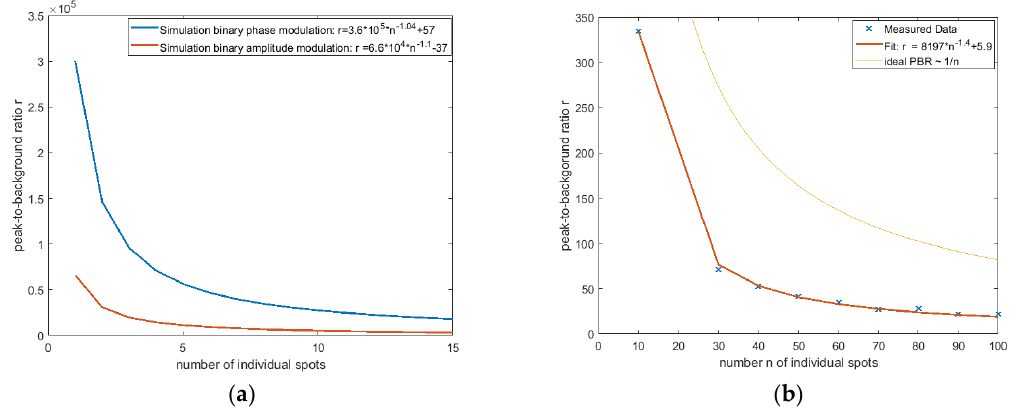
Figure 7 . Mean peak-to-background ratio in dependence of the number of foci created on the sample. ( a ) Comparison of simulated binary phase-only modulation as with our FSLM and simulated binary amplitude modulation as with a digital micromirror devices (DMD). On average, binary phase-only modulation yields an about 6 times higher PBR as well as a lower increase in background noise with higher spot number as indicated by the lower exponent of n . ( b ) Measured Data using the fast FSLM. Due to the design of the modulator and the overall setup, only 11.1% of the light arriving on the modulator is available on the sample surface. The maximum available power density in one spot, however, can be estimated to 1.5 W/mm 2 . This is three orders of magnitude above the EC50 for activating ChR2, which is 1 mW/mm 2 [40]. For stimulating one or only a few neurons, the maximum power density can be easily adjusted using neutral density